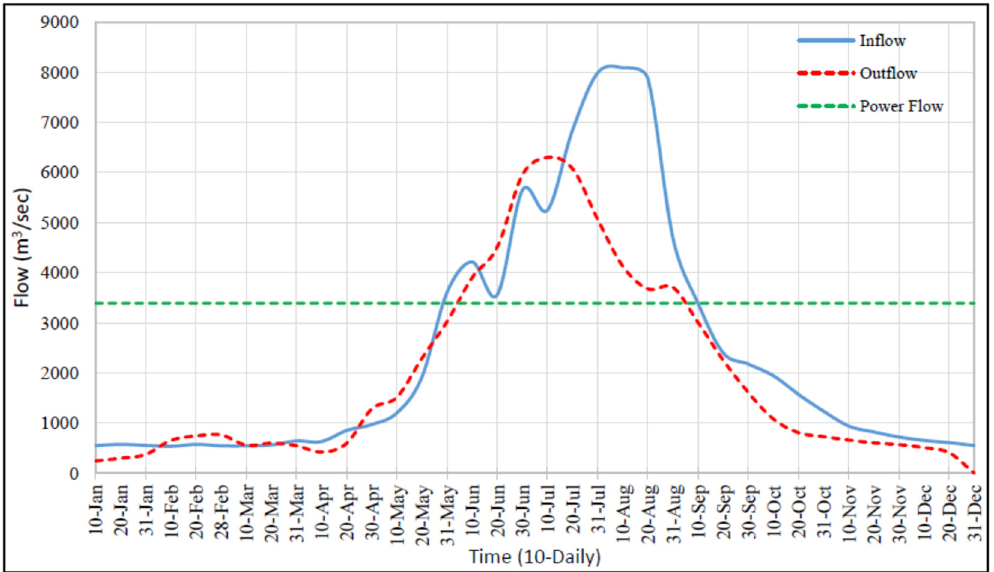
Figure 29. Inflow-Outflow Hydrograph of year 2009.